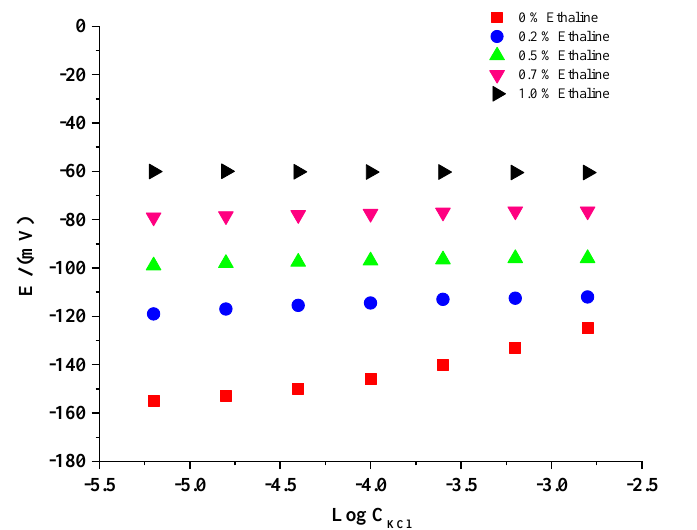
Figure 2. Selectivity coefficients of the fabricated Ag/AgCl microelectrode in the presence of different ethaline concentrations.